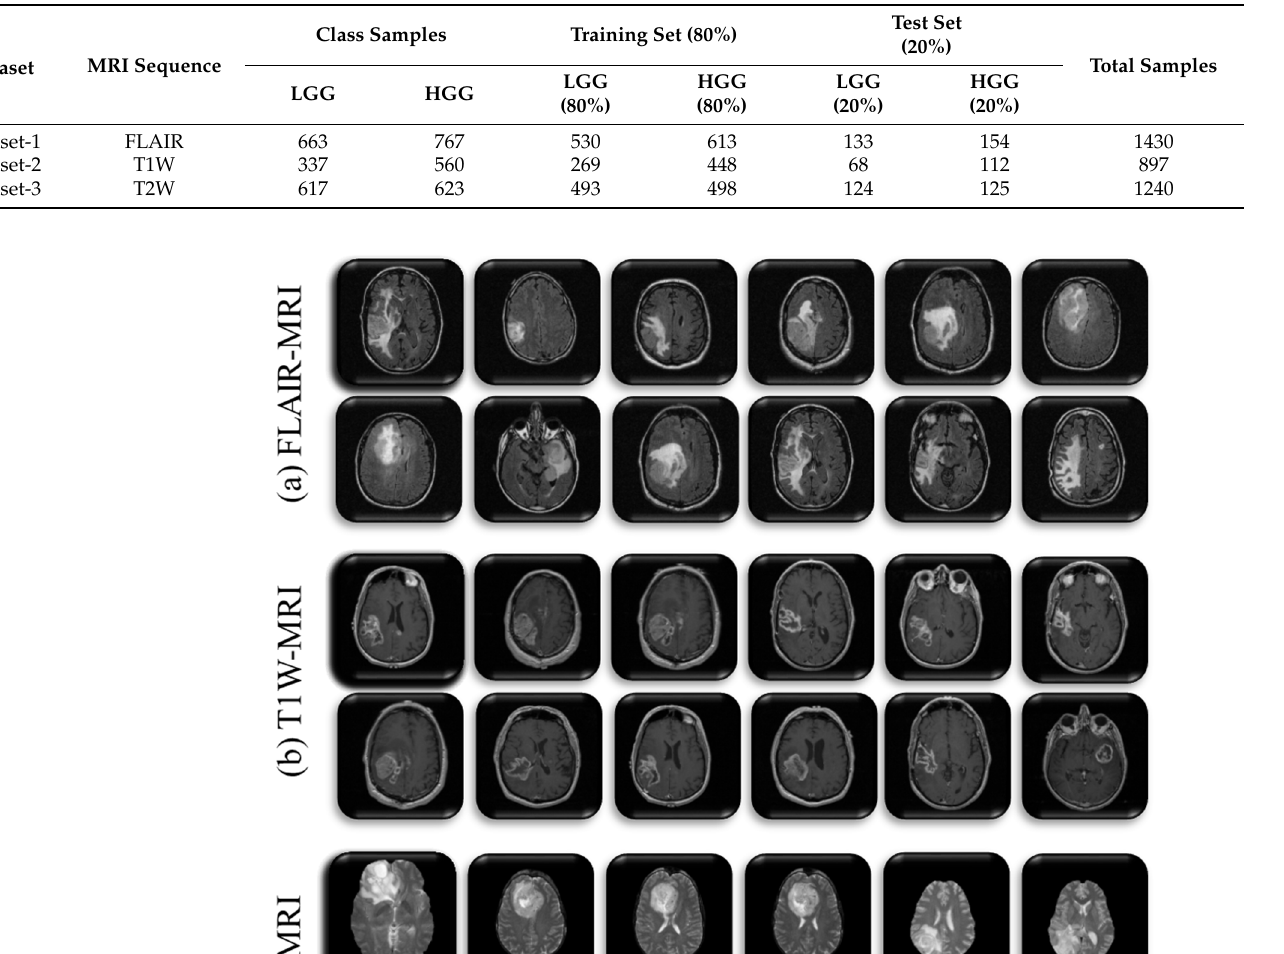
Table 1. Sample details of clinically relevant datasets.